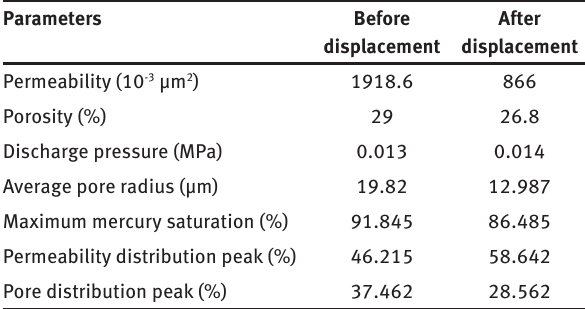
Table 3: Pore structure parameters of cores.